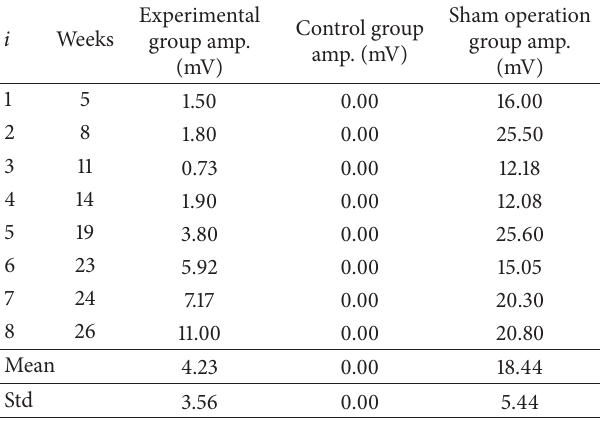
Table 1: The CMAP amplitudes in three groups at each time